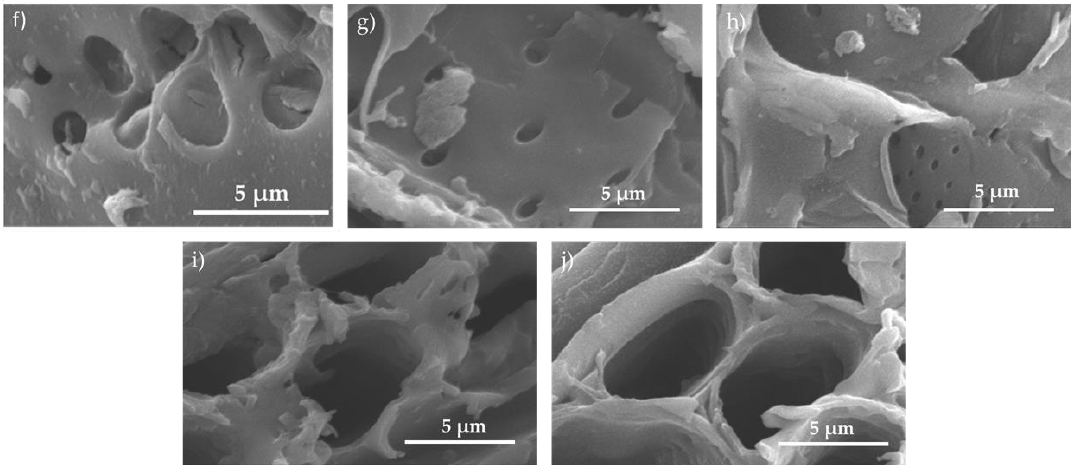
Magnification at 6500×. Figure 6. Scanning Electron Microscope (SEM) images of untreated and chemical treated RW biochar pyrolysed at 850 °C. ( a ) untreated RW850; ( b ) post acid RW; ( c ) post alkali RW; ( d ) pre-treated acid RW; ( e ) pre-treated alkali RW; ( f ) untreated RW850; ( g ) post acid RW; ( h ) post alkali RW; ( i ) pre-treated acid RW; ( j ) pre-treated alkali RW.